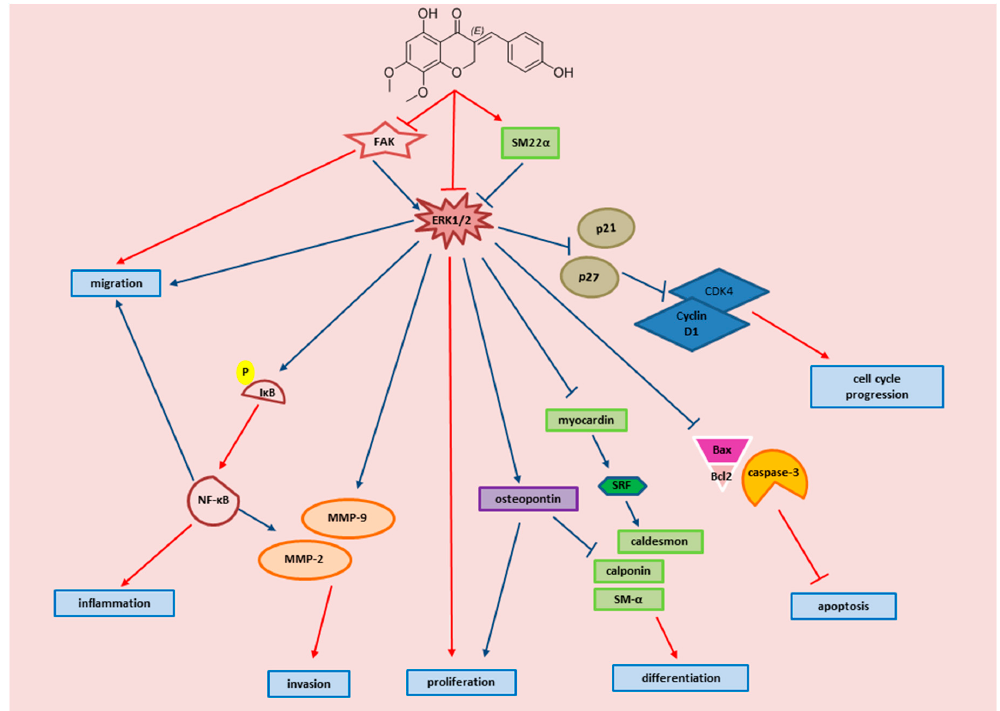
Figure 12. Schematic representation of the proposed signaling pathway by which MP attenuates FBS-induced inflammation of arteriolar SMC. The diagram displays key events of VSMC inflammation, and the molecular effectors by which MP attenuates these events. Red arrows are established by our study, blue arrows are established as referenced below: FAK → ERK1 / 2[136,137]; SM22 α → ERK1 / 2[138]; ERk1 / 2 → osteopontin [139]; ERK1 / 2 → p21 / p27 [71]; ERK1 / 2 → caspase-3, BAX / Bcl2 [140,141]; Osteopontin → proliferation [142]; Osteopontin → α SM and calponin [119]; p21, p27 → Cyclin D1 / CDK4 [143,144]; NF- κ B → MMP-2, MMP-9 [145–147]; NF- κ B → proliferation, migration [148]; NF- κ B → cyclin D1